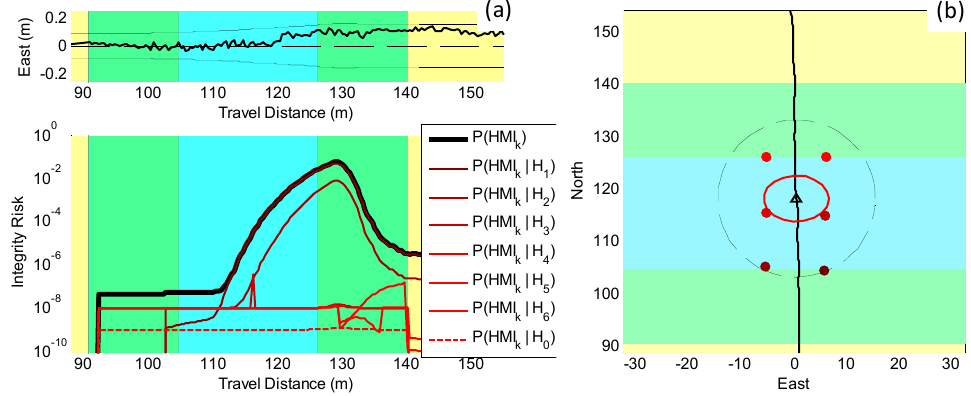
Figure 6. Experimental results accounting for UOs ( a ) P ( HMI k )-bound contributions for each unmapped object (UO) hypothesis for the preliminary experimental dataset: the overall risk is the thick black line. ( b ) Color-coded subsets identifying which landmark is occluded by a UO under each one of the six single-UO hypotheses.